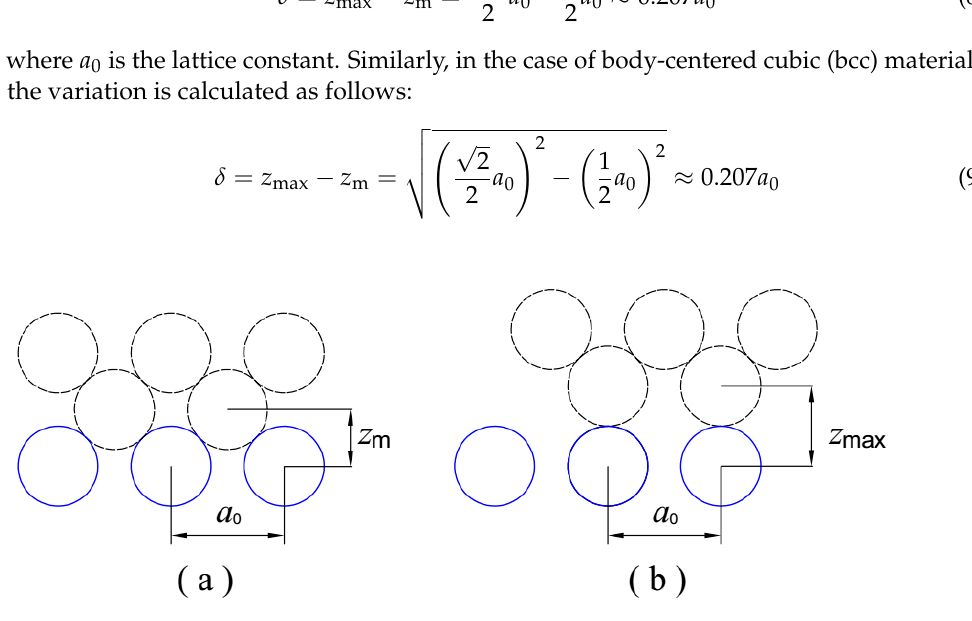
Figure 3. Variation in interfacial space. ( a ) Minimum space of fcc metals; ( b ) maximum space of fcc metals.